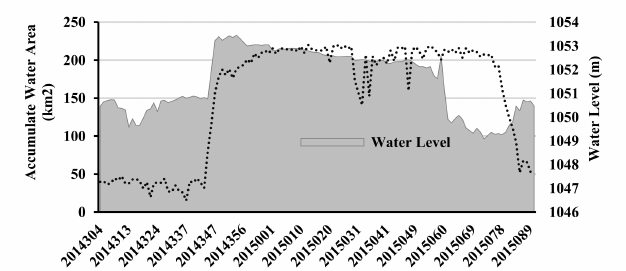
Figure 5. Cumulative water inundation area and daily water levels in the study area from 1 November 2014 to 1 April